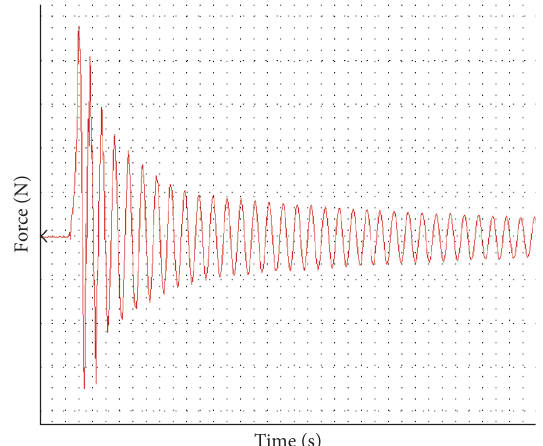
Figure 3: Ozurdex injection data. 𝑥 -axis is time in seconds. 𝑦 -axis is force in Newtons. Maximum force was measured from baseline to maximum value in the 𝑦